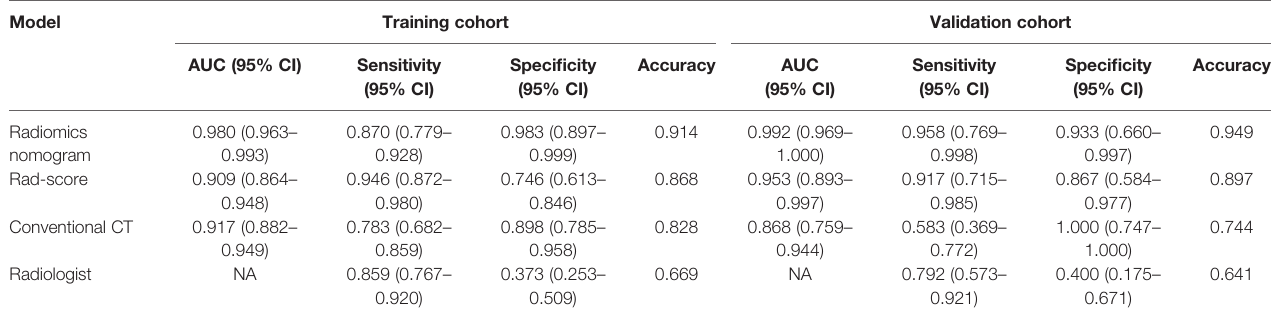
TABLE 3 | Predictive performances of radiomics nomogram, Rad-score, conventional CT model, and judgment by radiologists in the training and validation